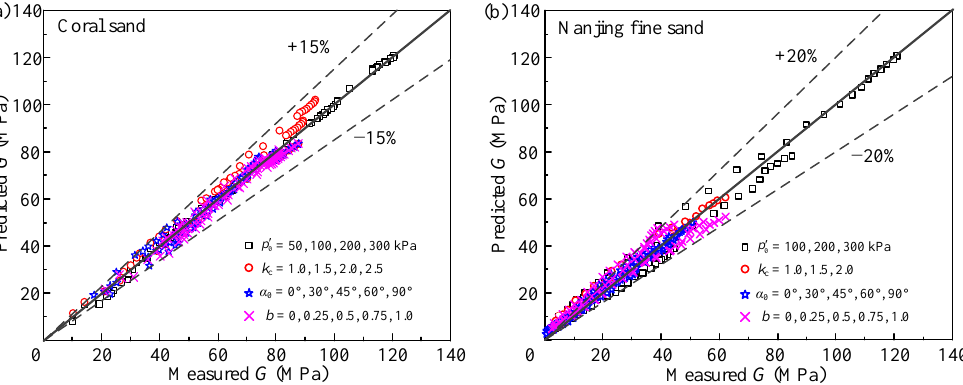
Figure 15. The correlation between the experimental G versus predicted G of ( a ) coral sand and ( b ) Nanjing fine sand under various consolidation conditions.